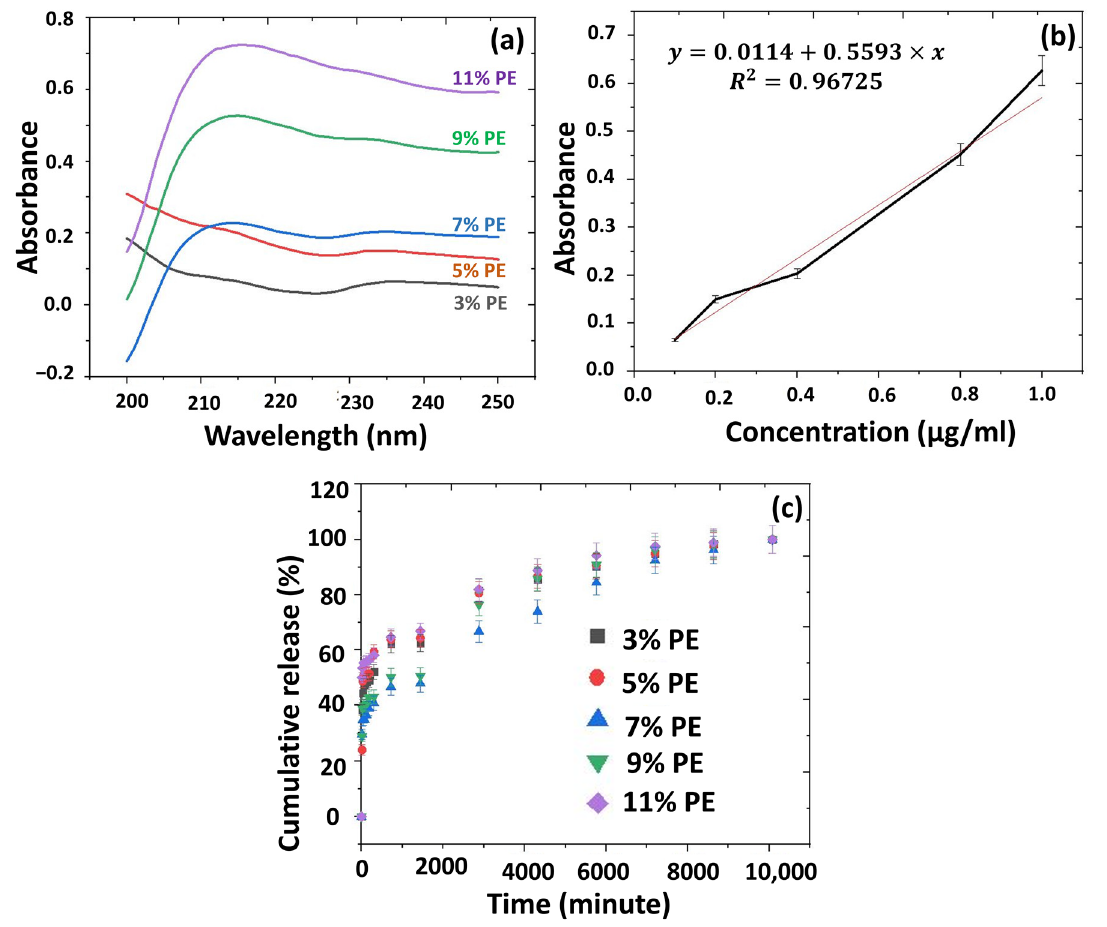
Figure 8. The calibration curve ( a ) and absorbance ( b ) graphs of the PPE: PSE; the cumulative release graph of the extracts from the scaffolds ( c ).